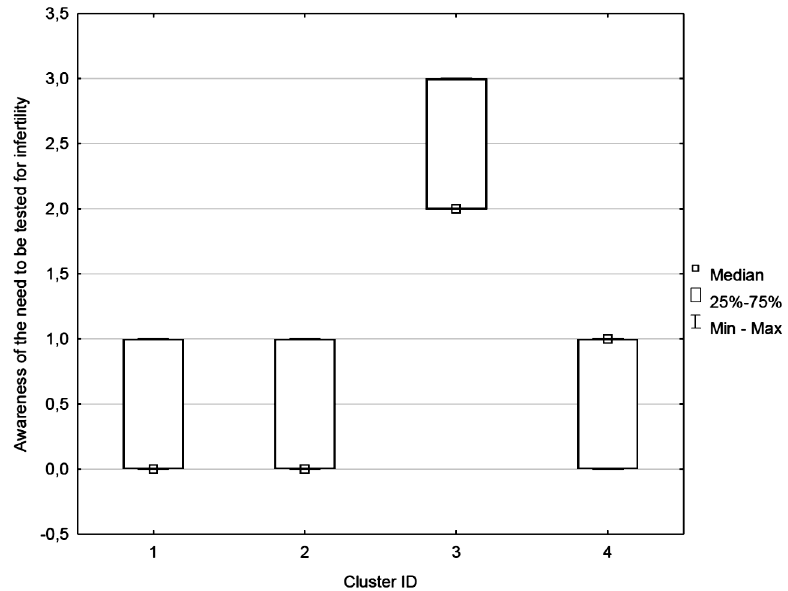
Figure 4. Level of actual knowledge about the need for testing for infertility